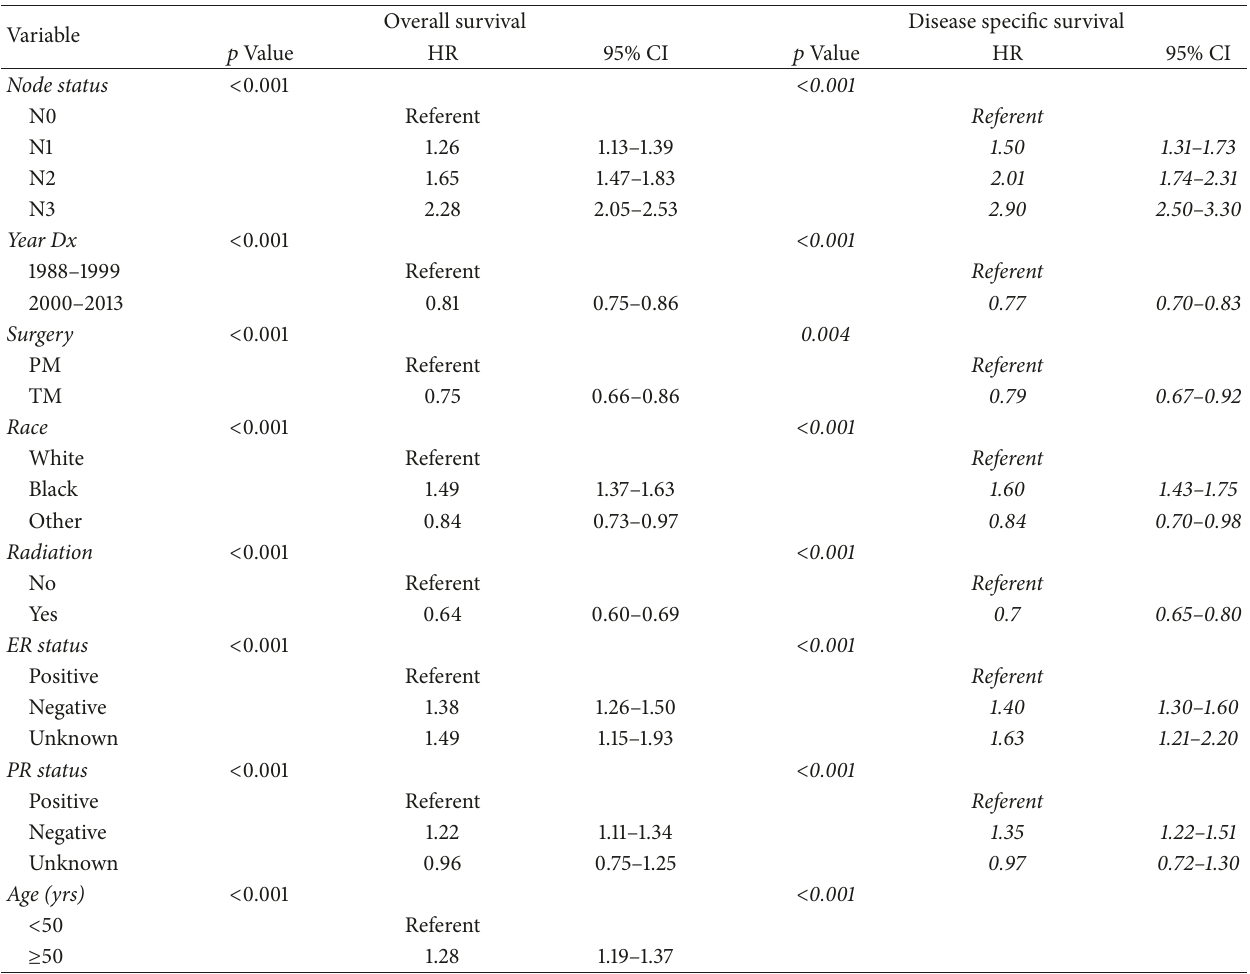
Table 2: Cox proportional hazards model for overall survival and disease specific